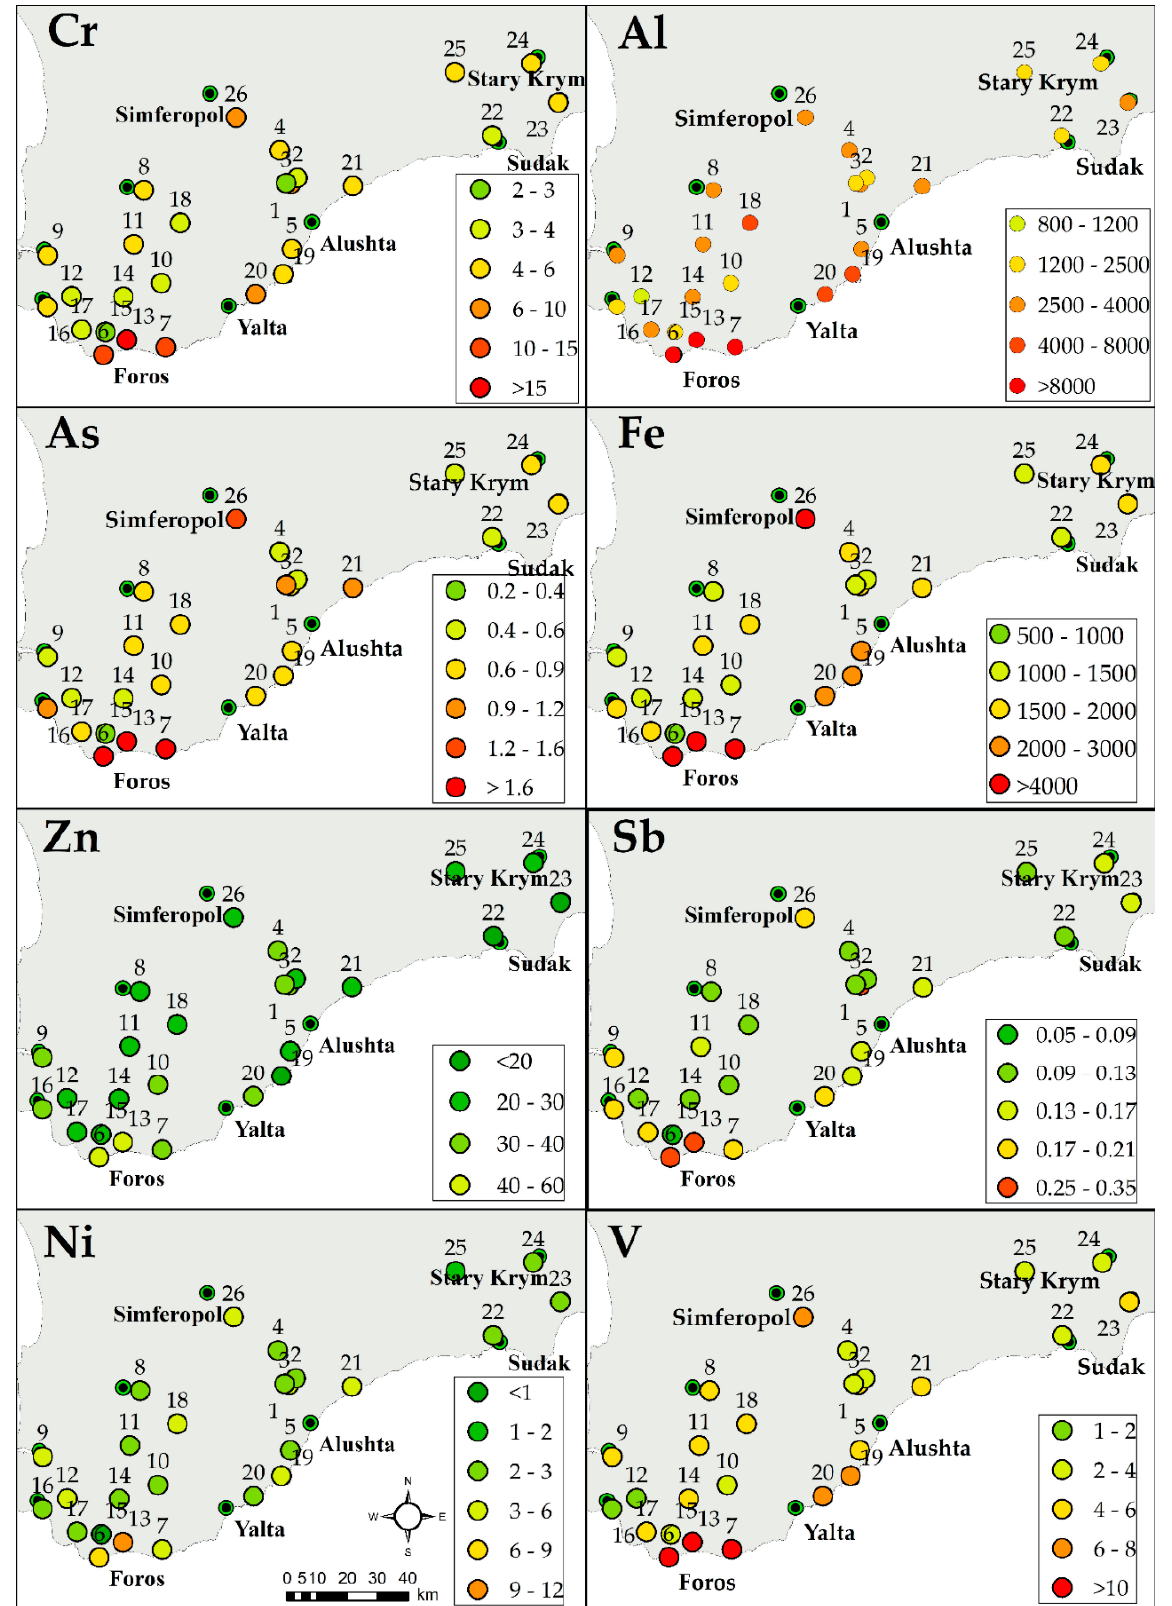
Figure 5. The mass fractions (mg/kg) of Cr, Al, As, Fe, Zn, Sb, Ni, and V in mosses from the mountain